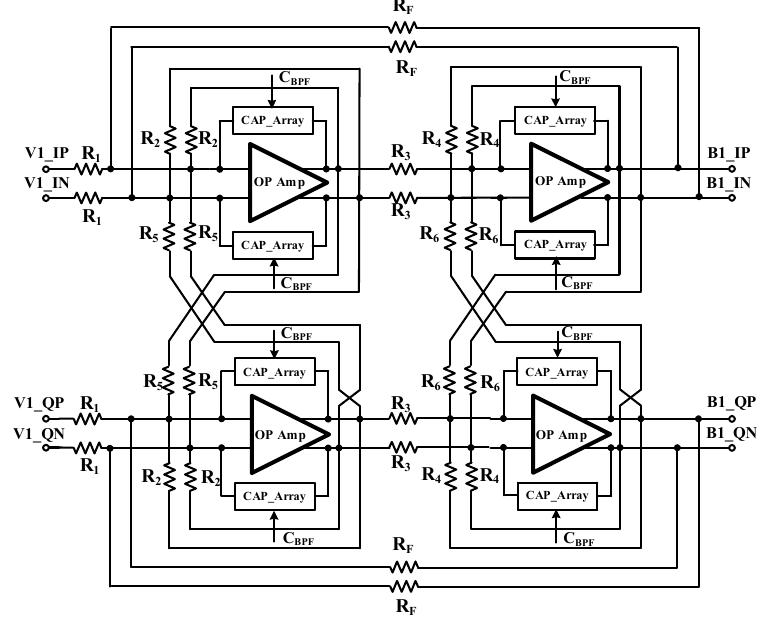
Figure 9. Block diagram of the second order complex BPF.